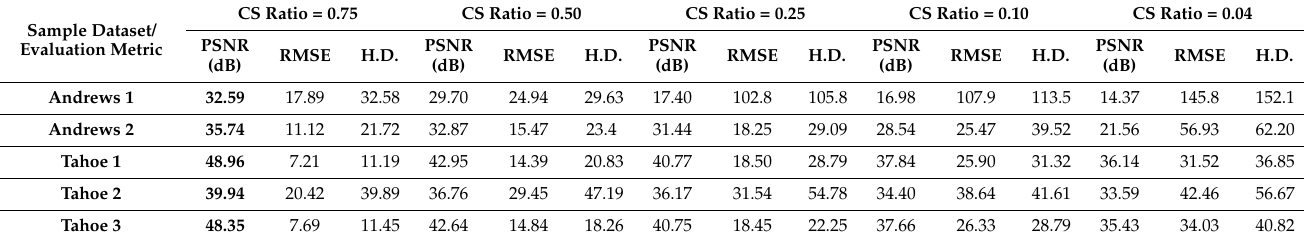
Table 2. Quantitative assessment of the reconstruction using our proposed ADCoSNet for the se- lected samples for different CS Measurement ratios based on the evaluation metrics — Peak Signal to Noise Ratio (PSNR in dB), Root Mean Square Error (RMSE), and Hausdorff distance (H.D.). Sample Da-